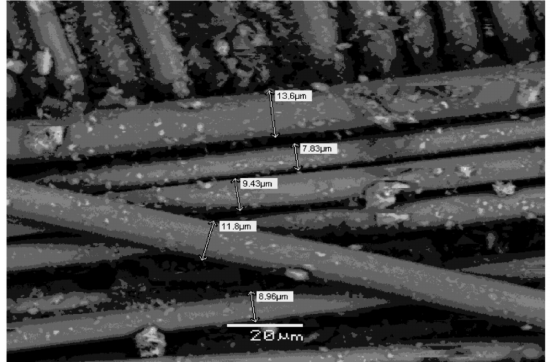
Figure 18. SEM image of the surface of very badly damaged textolite material (magnified 900 times). Exposed textile support glass fibres are visible, and on their surfaces are the remains after the destruction of the organic phase.